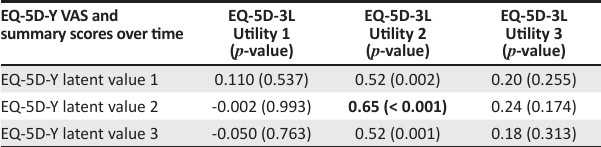
TABLE 1b: Correlation between the scores of the child and the caregiver over three days.